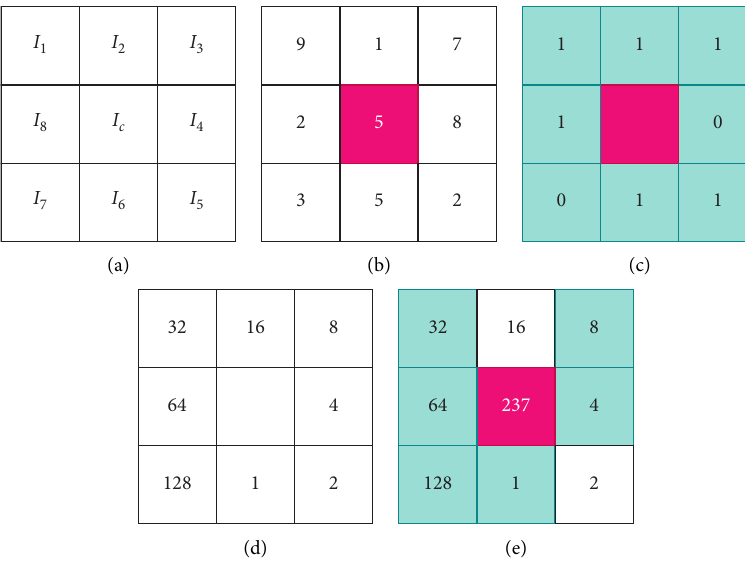
Figure 2: Local neighborhood difference mode.